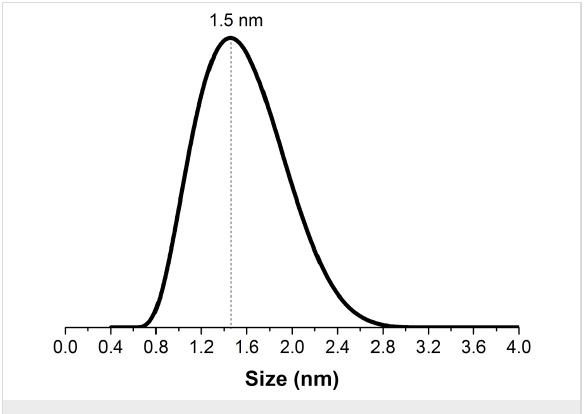
Figure 15: The dynamic light scattering (DLS)